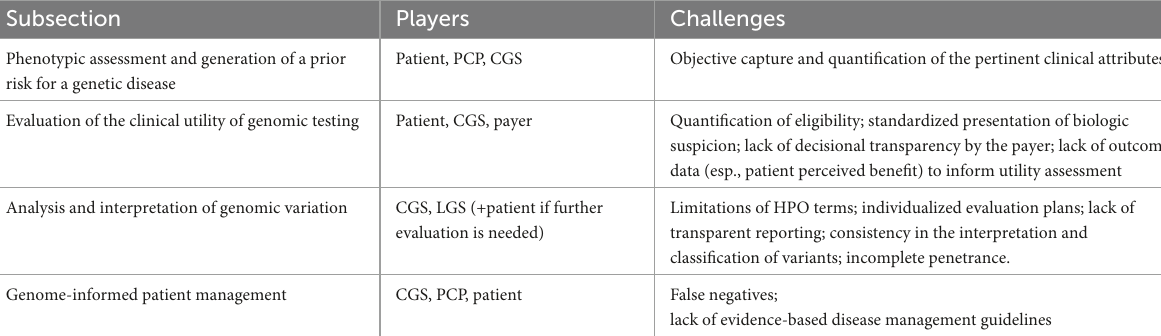
TABLE 2 Challenges and limitations in genomic